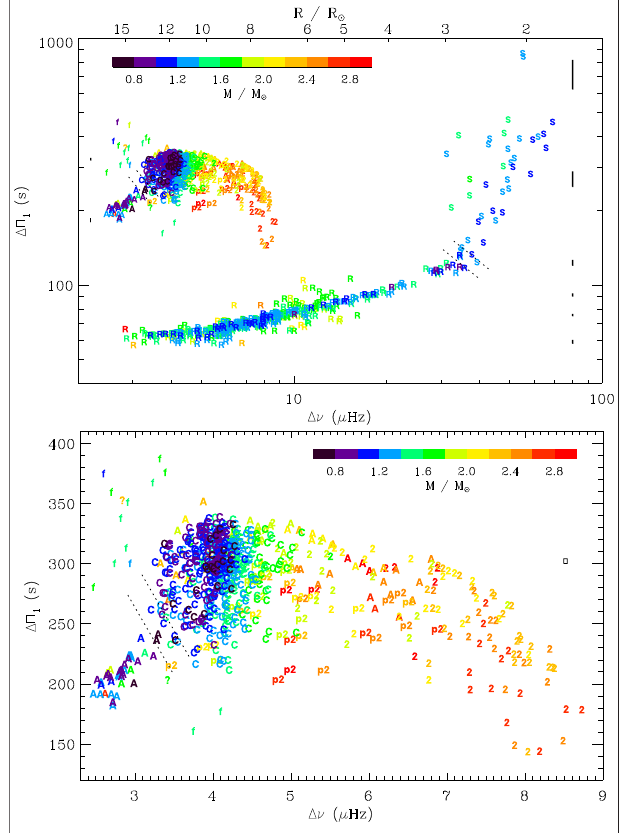
FIGURE 4 | Mixed-mode period spacing ( ΔΠ ) vs. the large frequency spacing ( Δ ] ) for a large sample of Kepler solar-like pulsators. Top: the seismic proxy for the stellar mass is indicated by the color code. The evolutionary states are indicated by S (subgiants), R (RGB), f (helium sub fl ash stage), C (red clump), p2 (pre-secondary clump), 2 (secondary clump), and A (stars leaving the red clump moving toward the AGB). The error boxes on the right side indicate themeanuncertainties,asafunctionof,for starson theRGB; for clump stars, uncertainties are indicated on the left side. Dotted lines indicate the boundaries between evolutionary stages. Bottom: zoom in the red-clump region. From Mosser et al. (Mosser et al.,